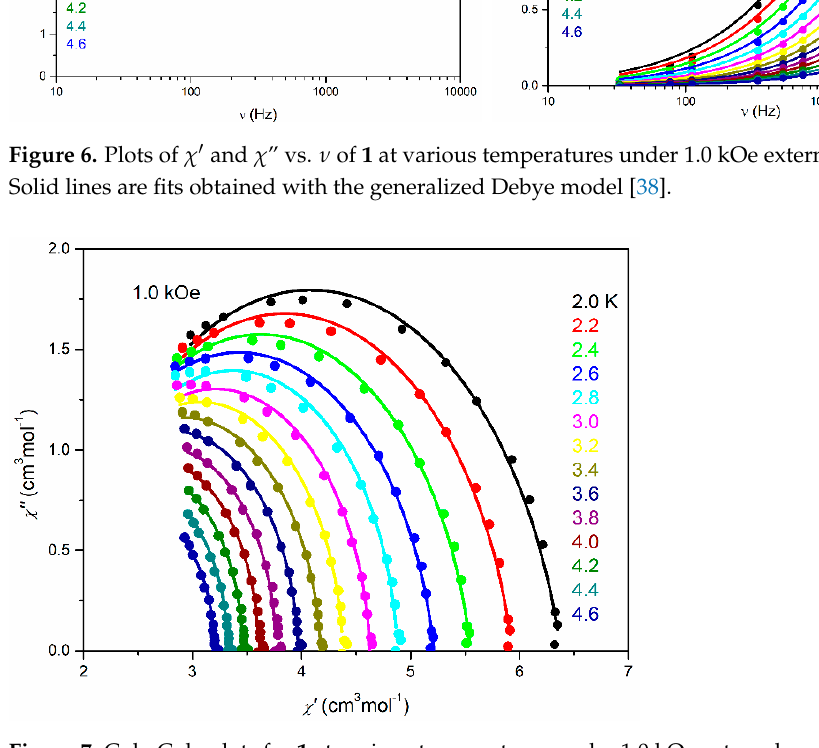
Figure 7. Cole-Cole plots for 1 at various temperatures under 1.0 kOe external magnetic field. Solid lines are fits obtained with the generalized Debye model [37].